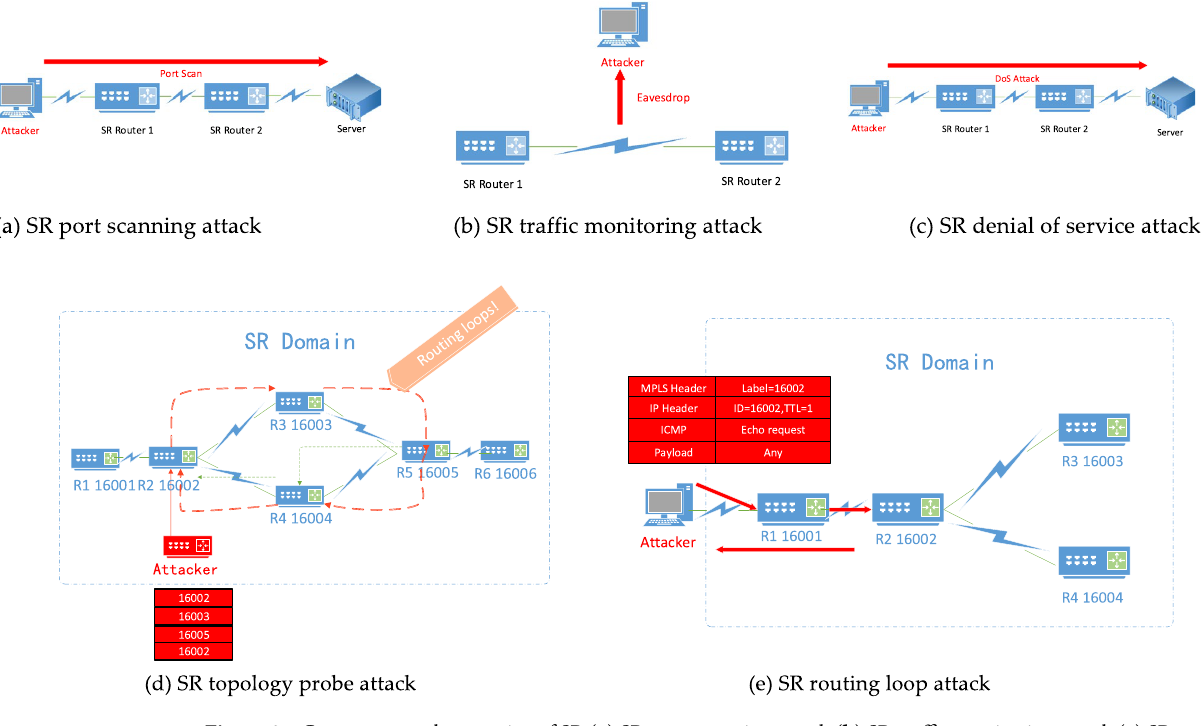
Figure 2. Common attack scenarios of SR ( a ) SR port scanning attack ( b ) SR traffic monitoring attack ( c ) SR denial of service attack ( d ) SR topology probe attack ( e ) SR routing loop